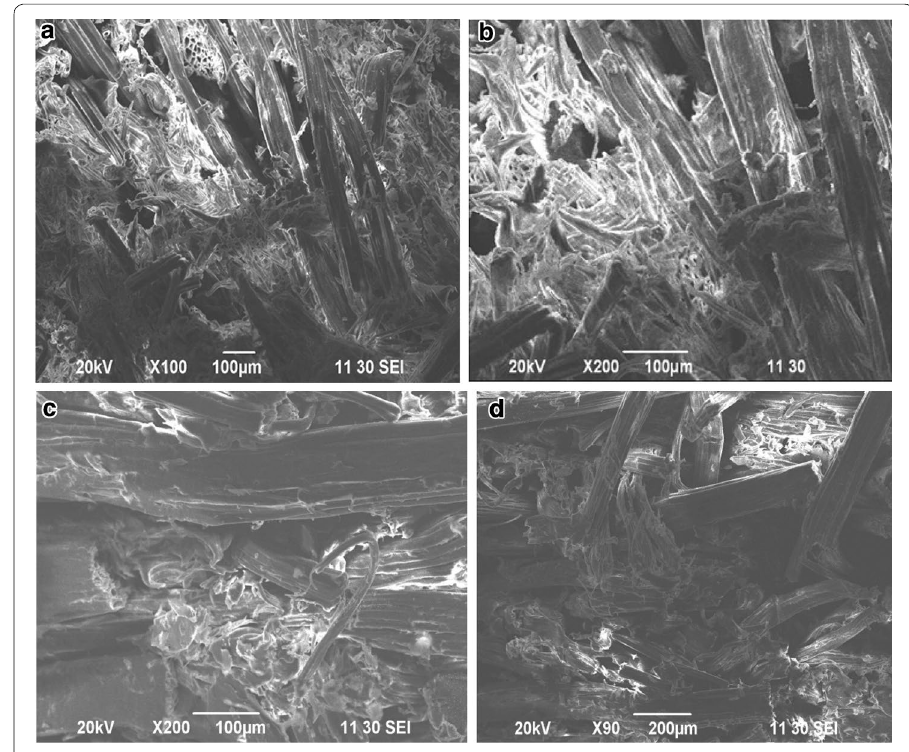
Fig. 12 SEM micrographs of Okra/PP composite ( a , b ) and Jute/PP composite ( c , d